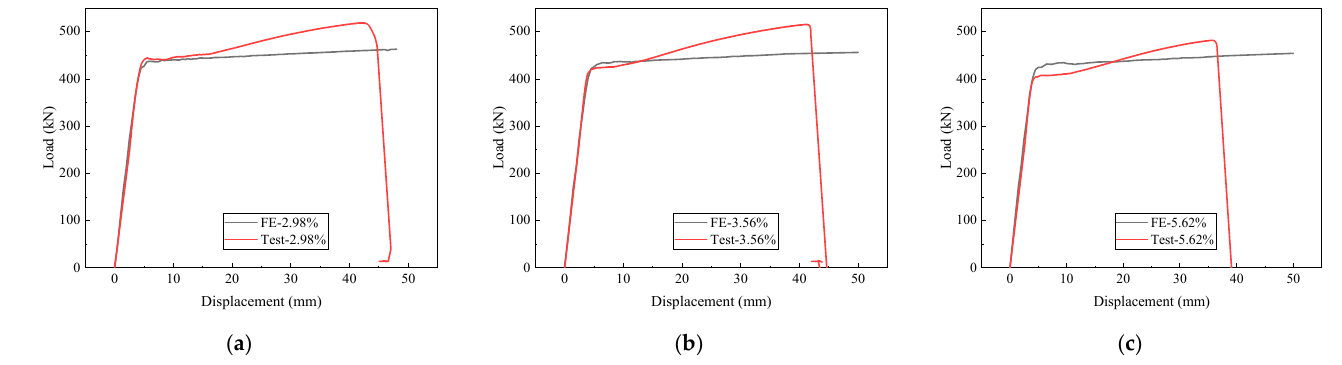
Figure 19. FE results of the corroded bolt-sphere joints with members: ( a ) w = 2.98%; ( b ) w = 3.56% ; ( c ) w = 5.62%. Table 12. Comparison of the FE and test results